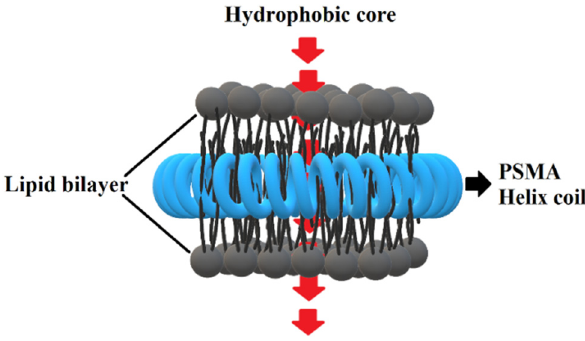
Figure 2: Polymer – lipid nanostructures with amphipathic α - helical PSMA coil arrangement around lipid